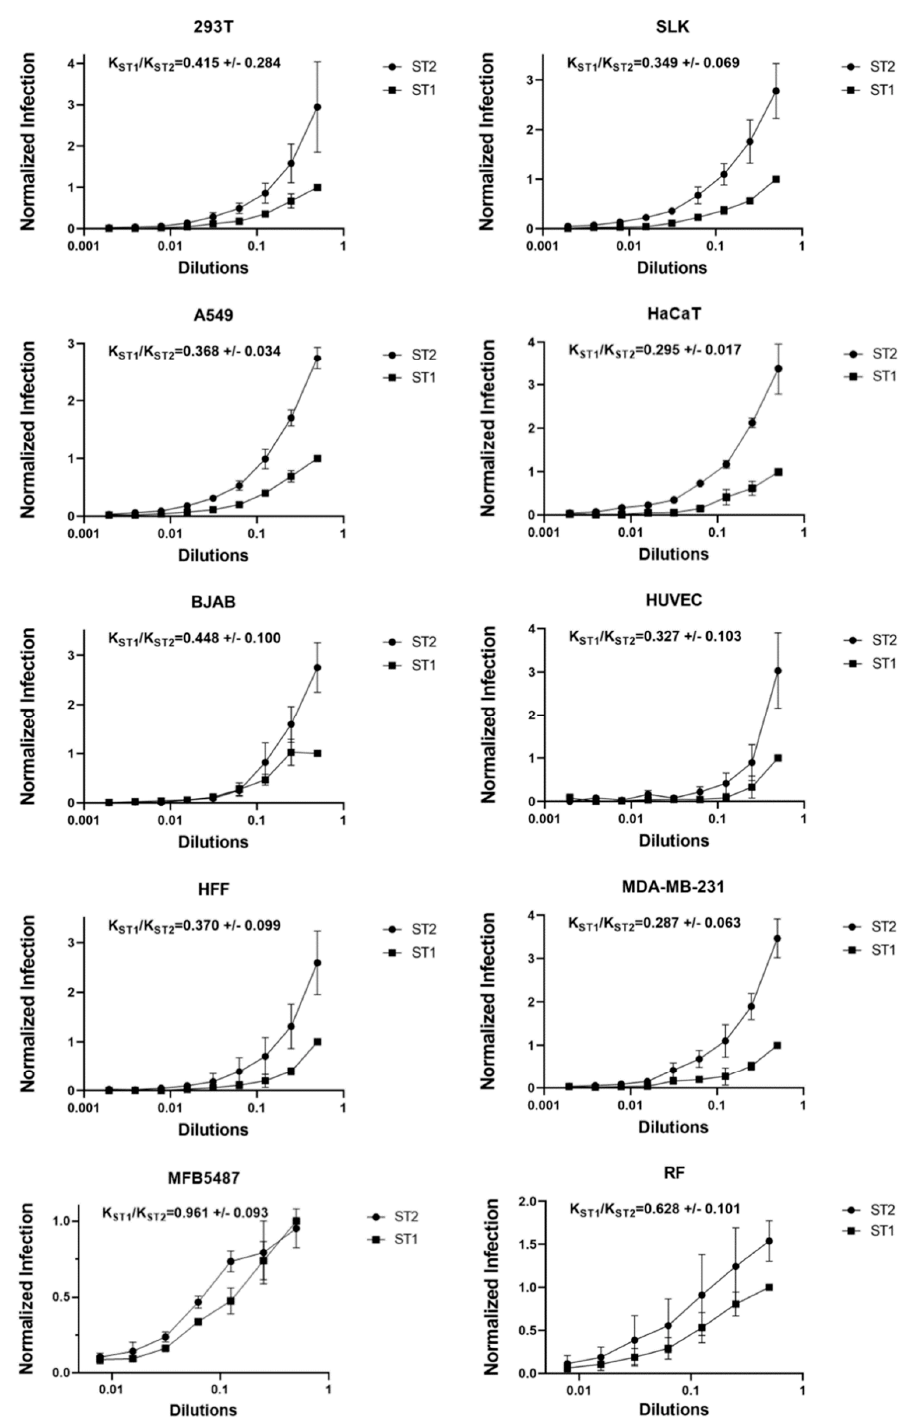
Figure 5. No evidence for env -associated differences in cell tropism. Infection of the indicated cells and cell lines after inoculation with increasing concentrations of ST1 or ST2. Infection was measured using flow cytometry to detect expression of YFP. The data show values normalized to infection with ST1 at the highest concentration. Curve fitting of infectivity on the different cell lines/cultures was performed using the built-in exponential equation for one phase association of GraphPad Prism version 9 to calculate K ST1 and K ST2 from the non-normalized data. The ratio between K ST1 and K ST2 represents the differences in infectivity between the viruses. Values represent the average of three experiments, error bars represent the standard deviation.